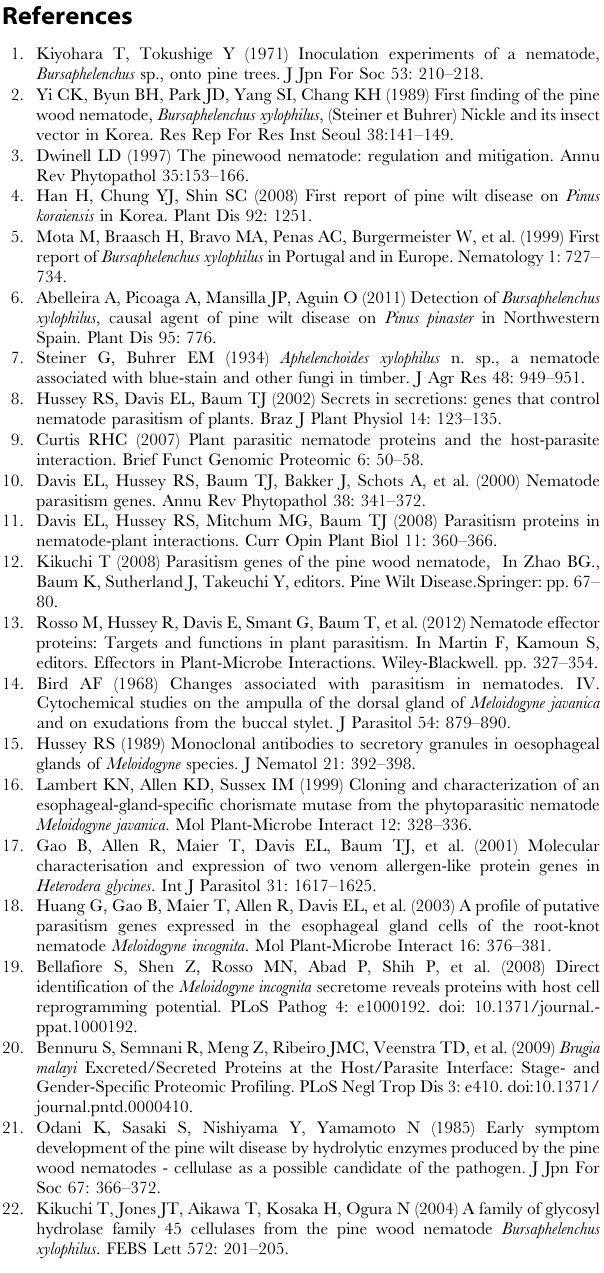
Table S4 The list of clusters of orthologous groups and genes shared between the secretome of Bursaphelenchus xylophilus (Bx) and Meloidogyne incognita (Mi). (XLS) Table S5 The list of clusters of orthologous groups and genes shared between the secretome of Bursaphelenchus xylophilus (Bx) and Brugia malayi (Bm). (XLS) Table S6 The list of carbohydrate active enzymes in the secretome of Bursaphelenchus xylophilus . (XLS) Dataset S1 Protein datasets used for secretome identi- fication.